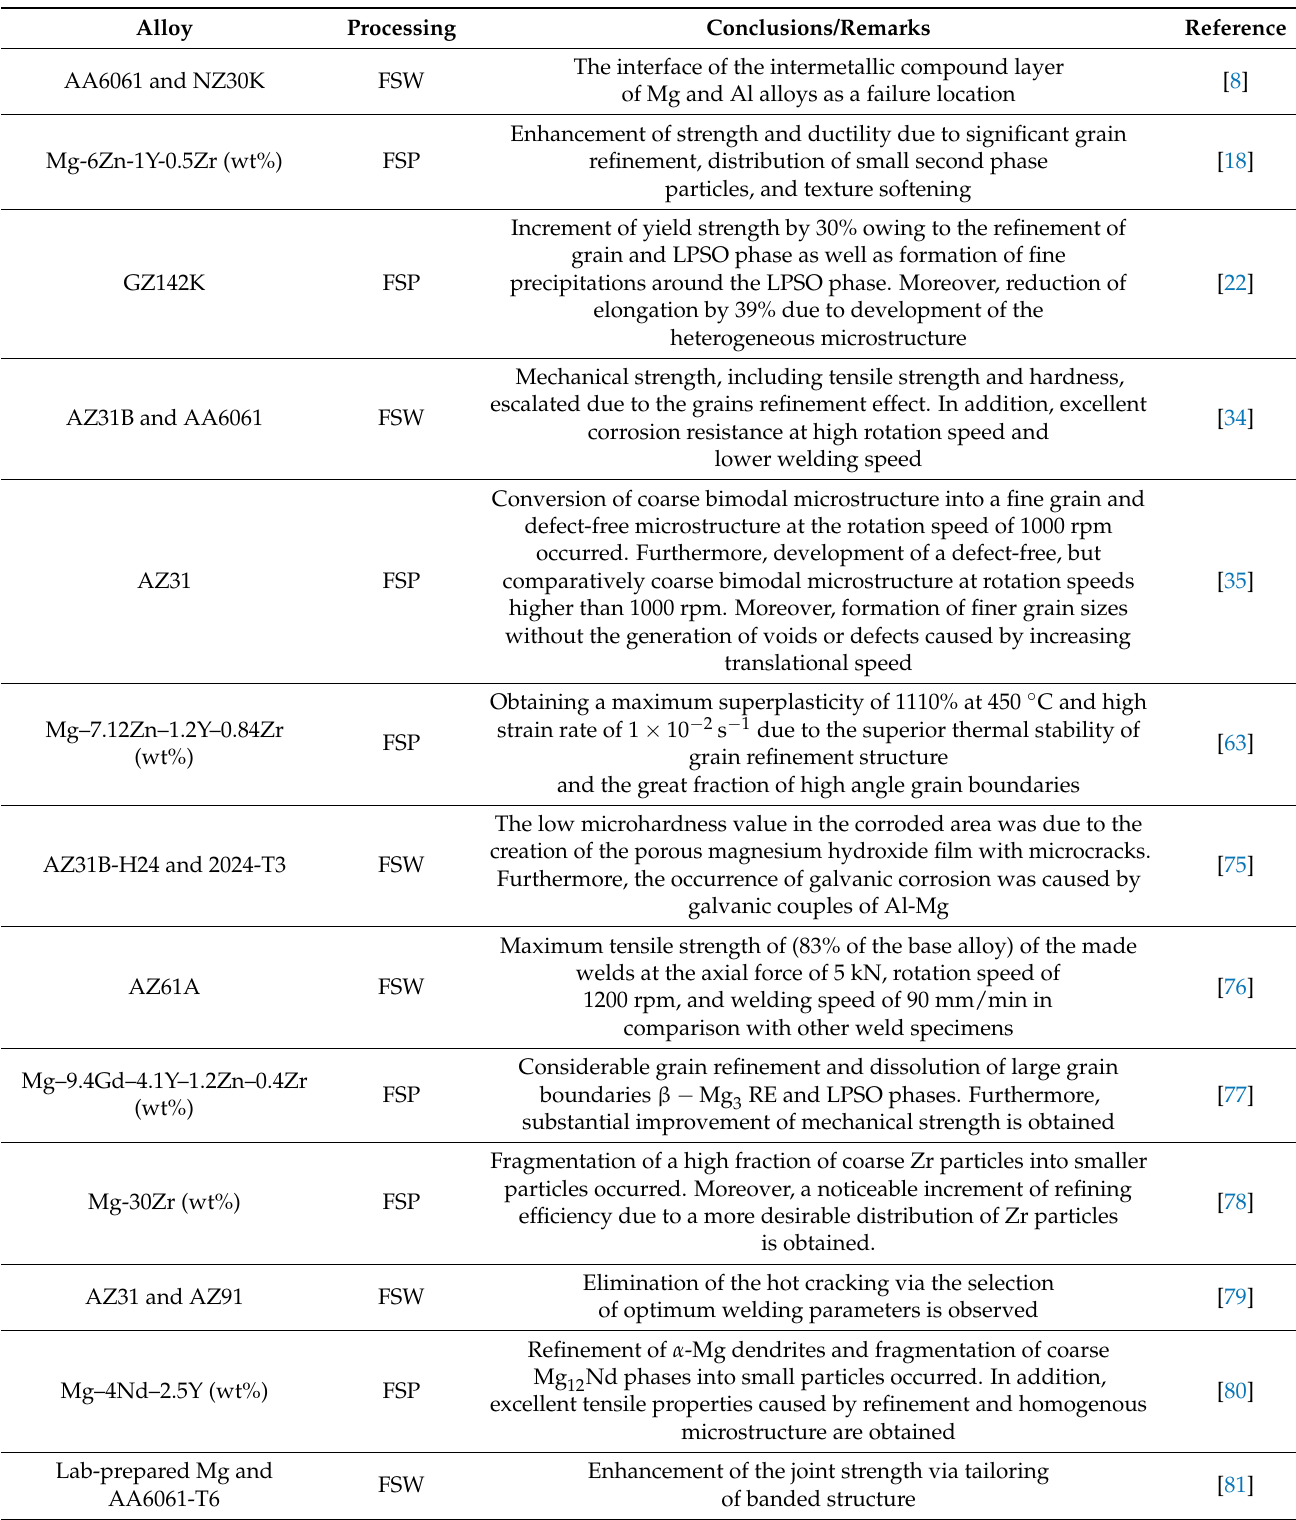
in Table 1. Based on Table 1, the FSW/FSP of Mg alloys is extremely affected by specific parameters. Table 1. Research summary of Mg-based alloys subjected to